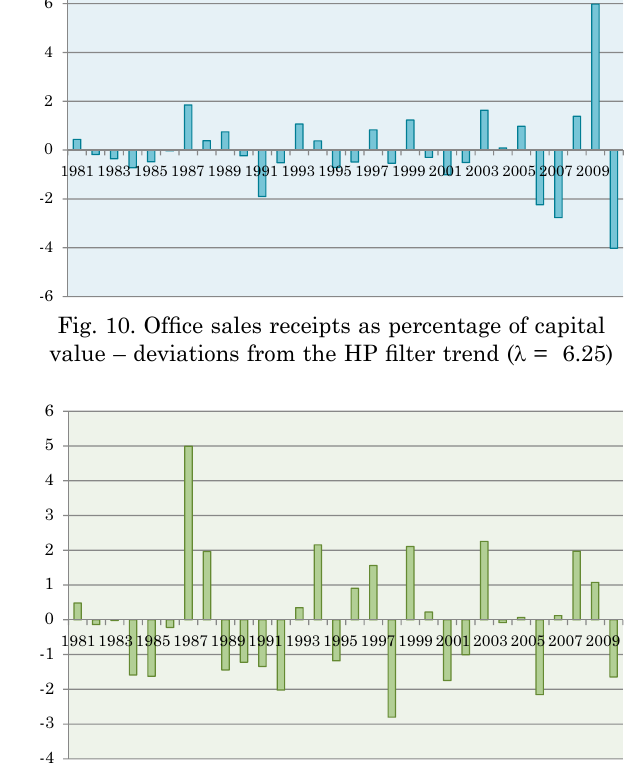
fig. 11. Industrial sales receipts as percentage of capital value – deviations from the HP filter trend ( λ =